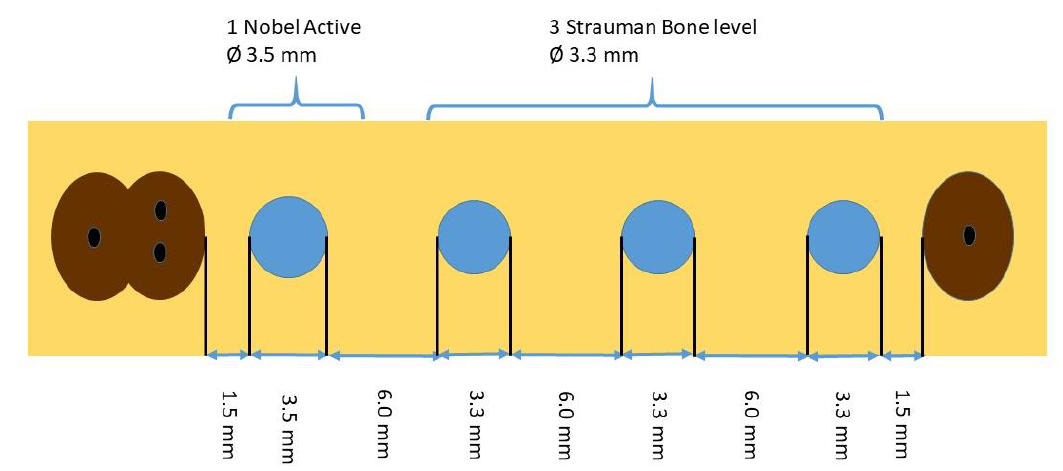
Figure 1. Allocation of implant positions.